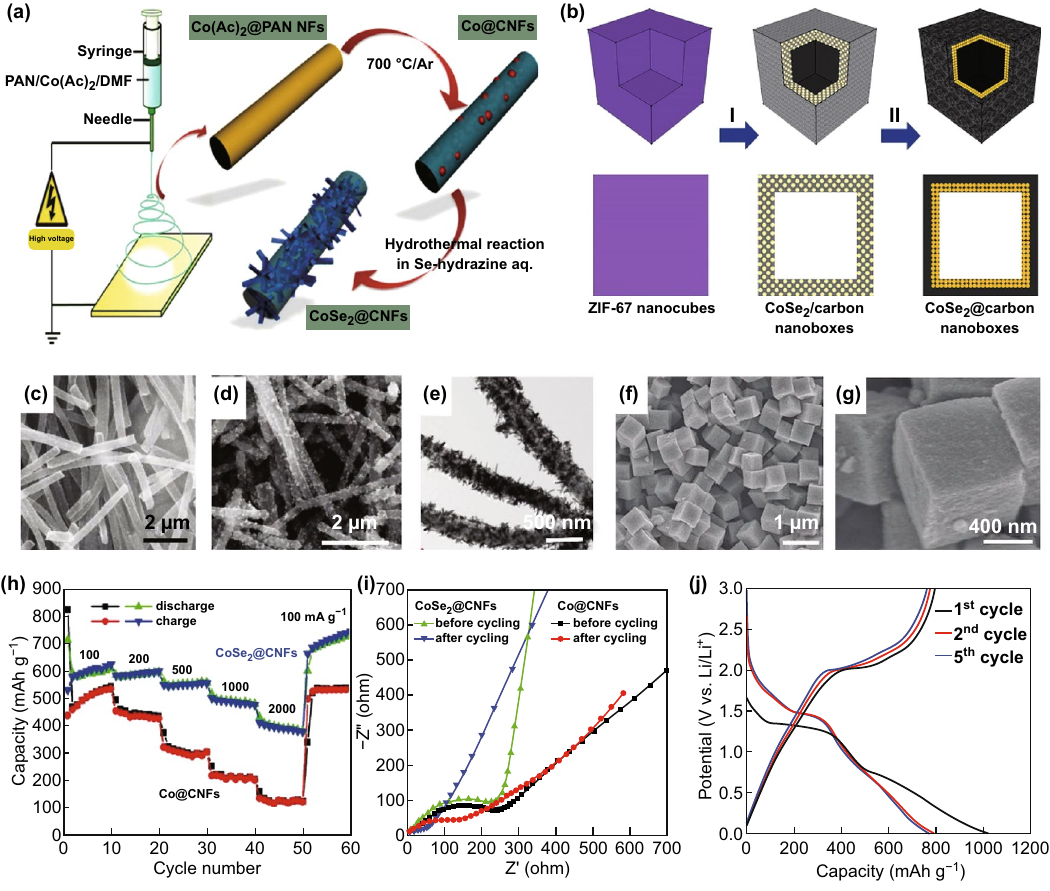
Fig. 2 a Schematic diagram of the synthesis of Co@CNF and CoSe 2 @CNF. b Schematic diagram of CoSe@CNF formation process. c SEM image of Co@CNFs. d SEM image of CoSe 2 @CNFs. e TEM image of CoSe 2 @CNFs. f, g Images showing annealing of a ZIF-67 nm cube and Se powder for 2 h and synthetic CoSe 2 /CNF FE-SEM under a nitrogen atmosphere at 350 °C. h Rate performance at different current densities. i The electrochemical performance of CoSe@CNF and CoSe 2 @CNF electrodes before and after cycling in the Nyquist diagram. j Discharge and charge voltage curves at a current density of 0.2 A g −1 . Adapted from Refs. [39, 40] with permission. Copyrights: 2016 (2017),